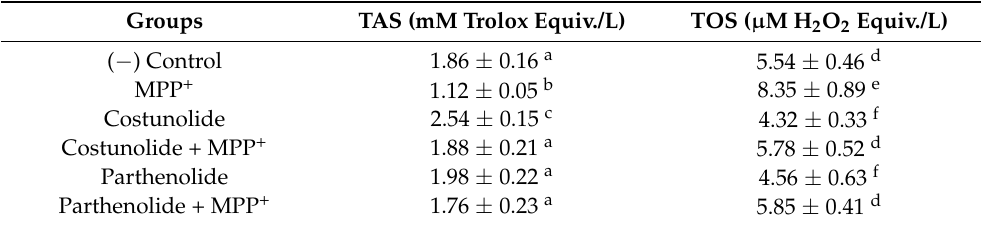
Table 2. Total antioxidant status (TAS) and total oxidant status (TOS) levels in an experimental in vitro Parkinson’s model treated with costunolide and parthenolide terpenoids for 24 h. One-way ANOVA and Dunnett tests were used for multiple comparison. Different letters in the same column present statistical significance from each value, p <